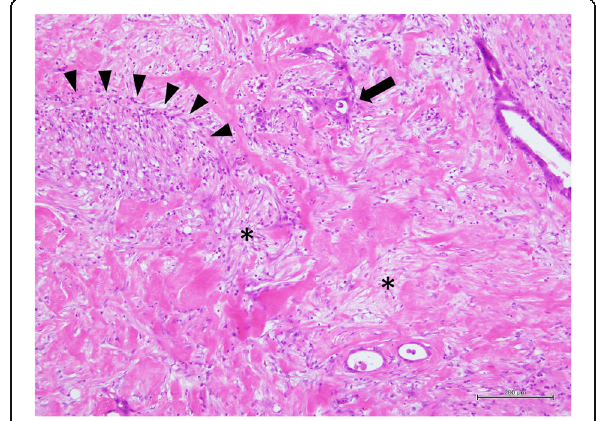
Fig. 3 Microscopic findings. Most of the tumor cells were organized by atypical cells (arrow) with growth of fibrous tissue (asterisks) and inflammatory cell infiltration